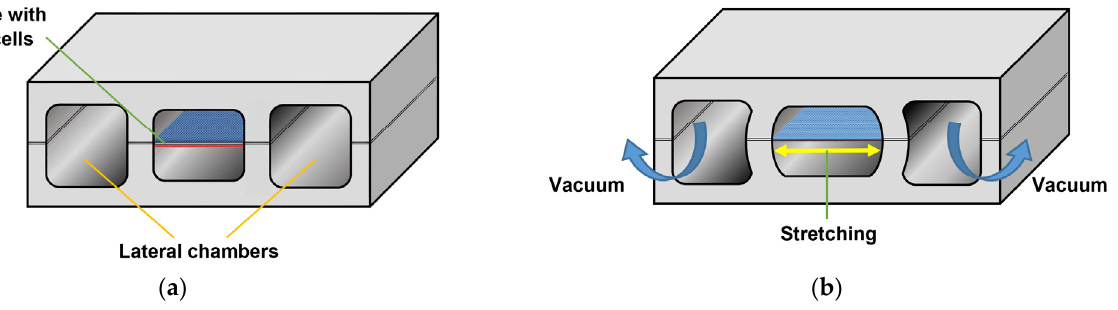
Figure 17. Schematic of the lung-on-a-chip developed by [104,105]: ( a ) in initial relaxed state; ( b ) by applying vacuum to the lateral microchambers, an elastic deformation in the membrane attached with alveolar epithelium and capillary endothelium cells mimics the mechanical distortion of the alveolar–capillary interface produced during the breathing process.